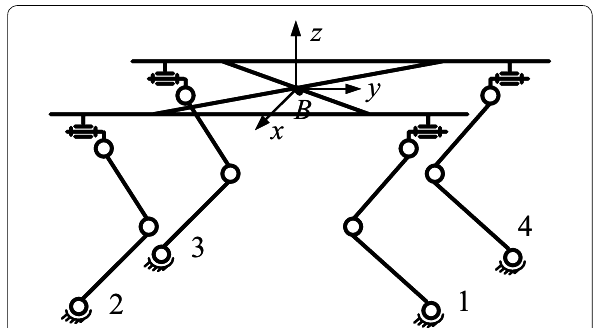
Figure 2 Equivalent mechanism of robot with four standing legs